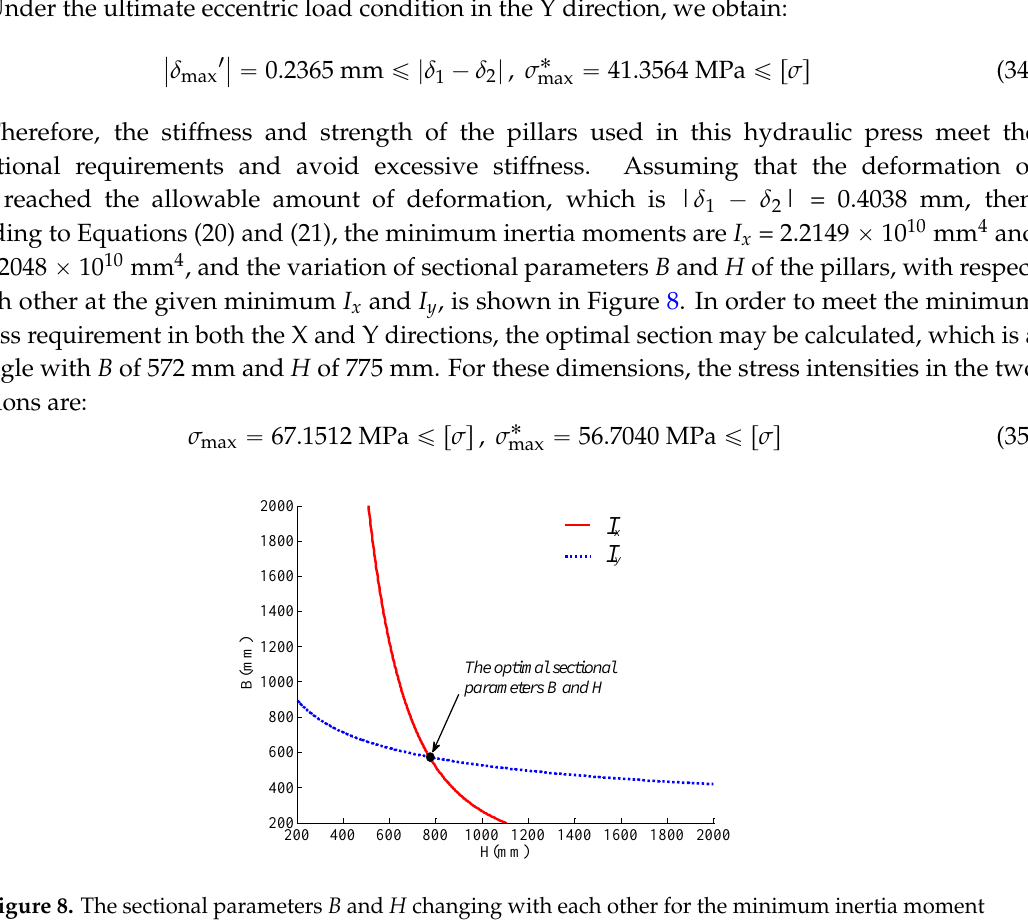
Table 2. The pillar material constants.